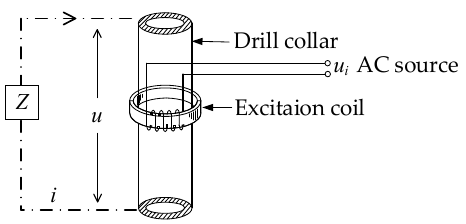
Figure 5. Diagram of the application of the inductive coupling principle in LWD.